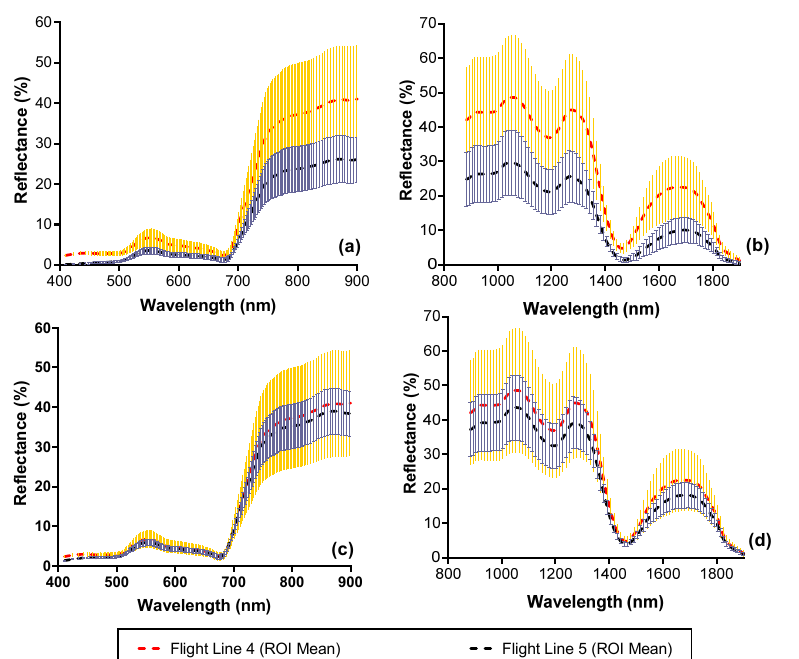
Figure 5. Mean and standard deviation of reflectance of mangrove vegetation covering 41.8 ha (67,000 pixels) from the CASI and SASI imagery before (black dashed line) and after (red dashed line) applying the BRDF correction. Plots a and b show the difference in reflectance spectra before correction for the CASI ( a ) and SASI ( b ). Plots c and d show the reflectance spectra for the CASI ( c ) and SASI ( d ) after correction. Error bars illustrate one standard deviation.